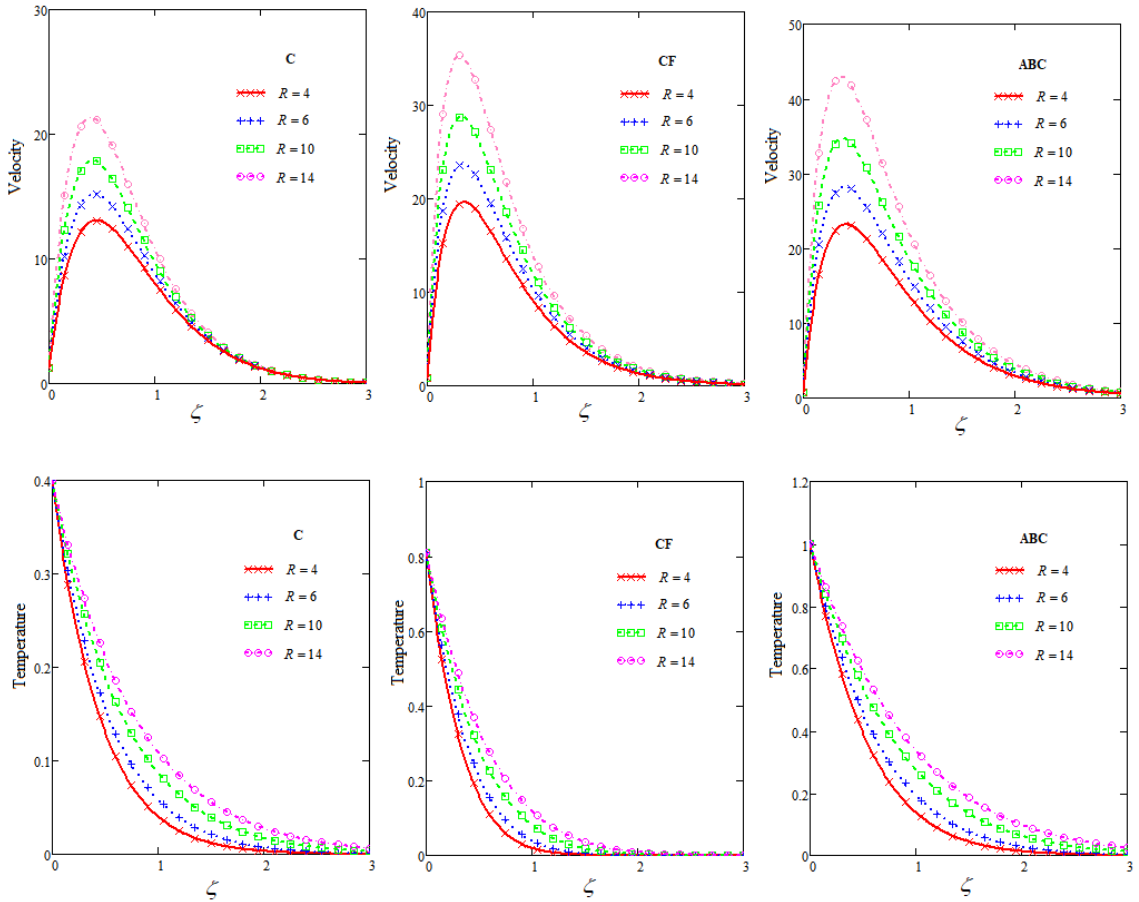
Figure 9. Velocity and temperature curves corresponding to C, CF and ABC with variable R where P r = 7, S c = 0.66, κ = 0.5, G m = 5, H = 3, S r = 3, G r = 10, K r = 2, M = 0.5, γ 1 = 0.1, h = 0.5, c = 1.05 and b = 0.75.